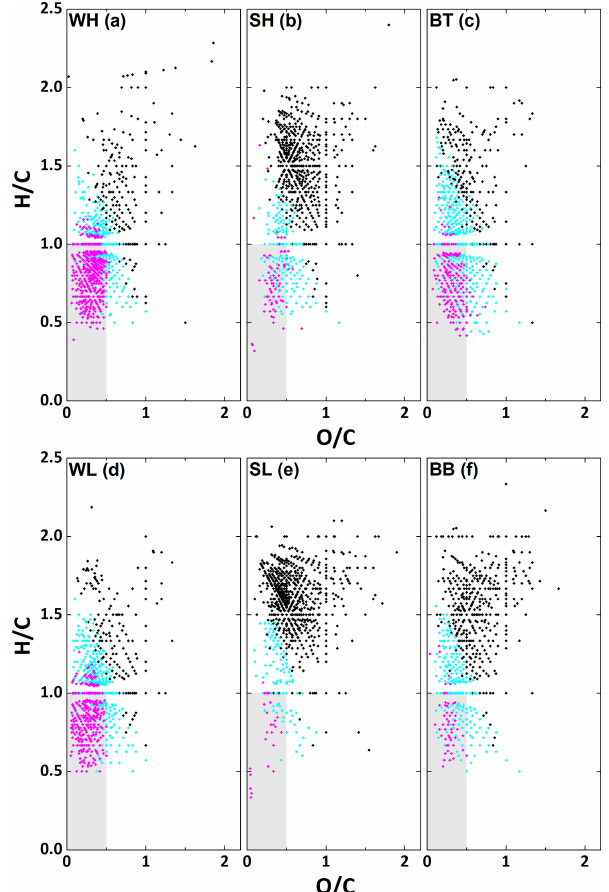
Figure 6. Van Krevelen plot for the WH, WL, SH, SL, BT and BB sample sets. Polycyclic aromatic (2.7143 ≤ Xc), monocyclic- aromatic (2.5000 ≤ Xc ≤ 2.7143) and non-aromatic (Xc ≤ 2.5000) formulae for all CHO and CHON ions present in the samples are indicated in magenta, cyan and black, respectively. The aromatic region is shaded in